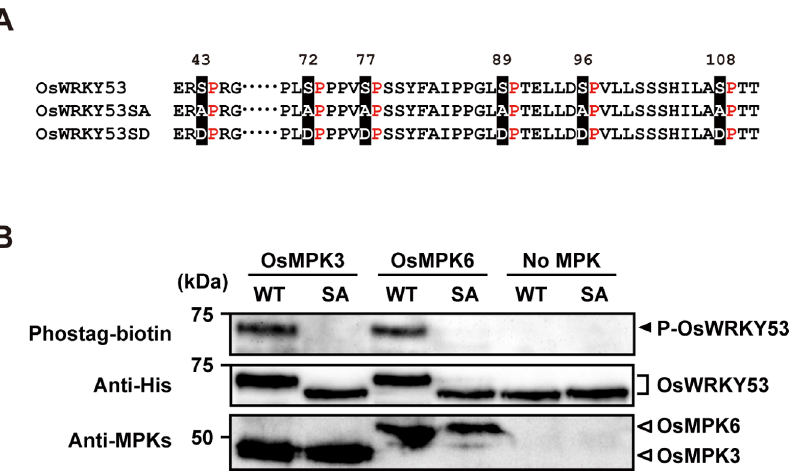
Figure 1. Invitro phosphorylation of OsWRKY53 by chitin-responsive OsMPKs. A , Putative MAPK phosphorylation sites in the SP cluster region of OsWRKY53, the loss-of-phosphorylation OsWRKY53 mutant with all 6 Ser substituted to Ala (OsWRKY53SA), and the phospho-mimicking OsWRKY53 mutant with all 6 Ser substituted to Asp (OsWRKY53SD). B , In vitro phosphorylation of OsWRKY53 by OsMPK3 and OsMPK6. Recombinant His-OsWRKY53 and His-OsWRKY53SA proteins were used as the substrate for rice mitogen-activated protein kinases (OsMPKs) activated by a constitutively active form of the rice MAP kinase OsMKK4 DD . Proteins separated by SDS-PAGE were blotted on membrane and probed with a Phostag- biotin antibody (top panel). The arrowhead indicates the position of phosphorylated OsWRKY53 (P-OsWRKY53). The membranes were reprobed followed by probing with an anti-His antibody to detect added substrate OsWRKY53 and OsWRKY53SA proteins (middle panel). OsMPKs in the reaction mixtures were also detected by immunoblot analysis with anti-OsMPK3 and anti-OsMPK6 antiserum (bottom panel). WT, native His- OsWRKY53; SA, His-OsWRKY53SA.